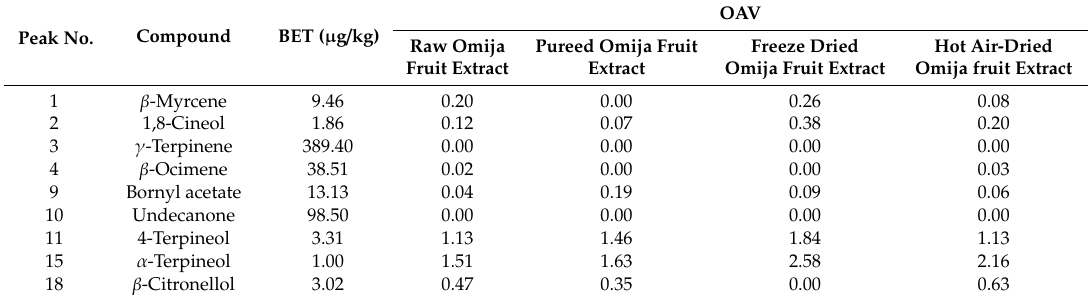
Table2. Bestestimatethreshold(BET)valuesandodoractivityvalues(OAVs)forkeyaromacompounds. Peak